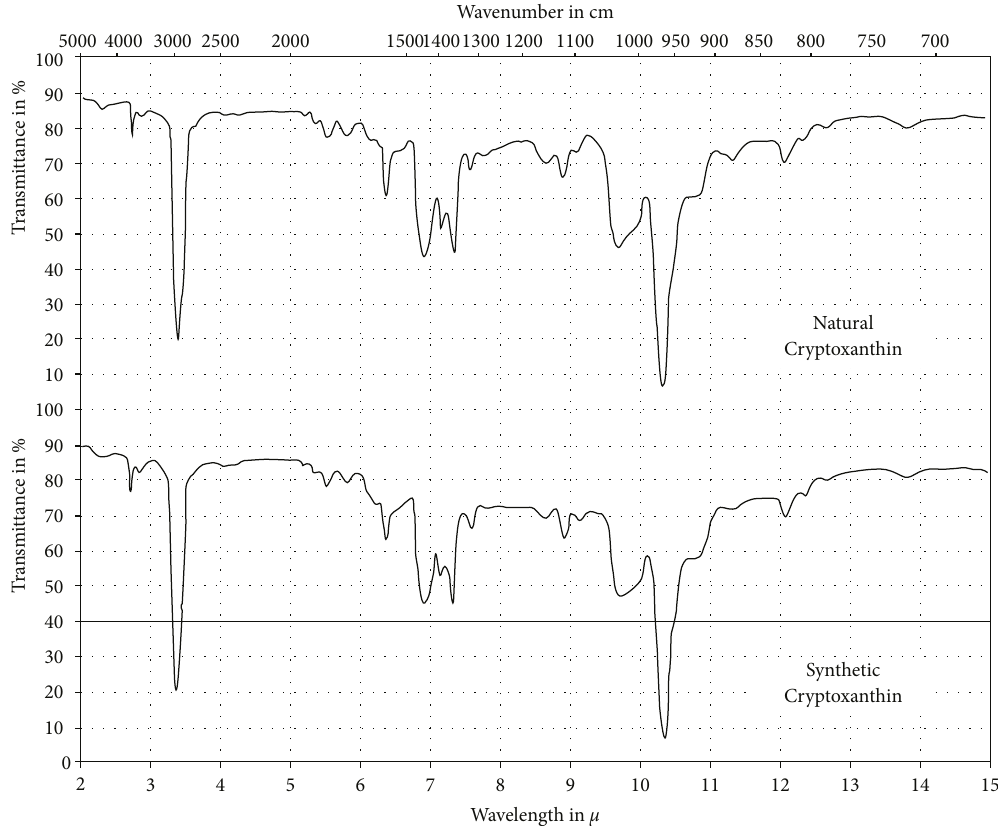
Figure 2: Experimental IR spectra of natural BCRY (at the upper part) and a synthetized BCRY (at the lower part). From 2 to 12 μ in chloroform and from 12 to 15 μ in carbon disul fi de (solutions approximately at 1%, KBr cell plate spacing of 1 mm). Reproduced with the authorization of John Wiley and Sons Publisher [47].